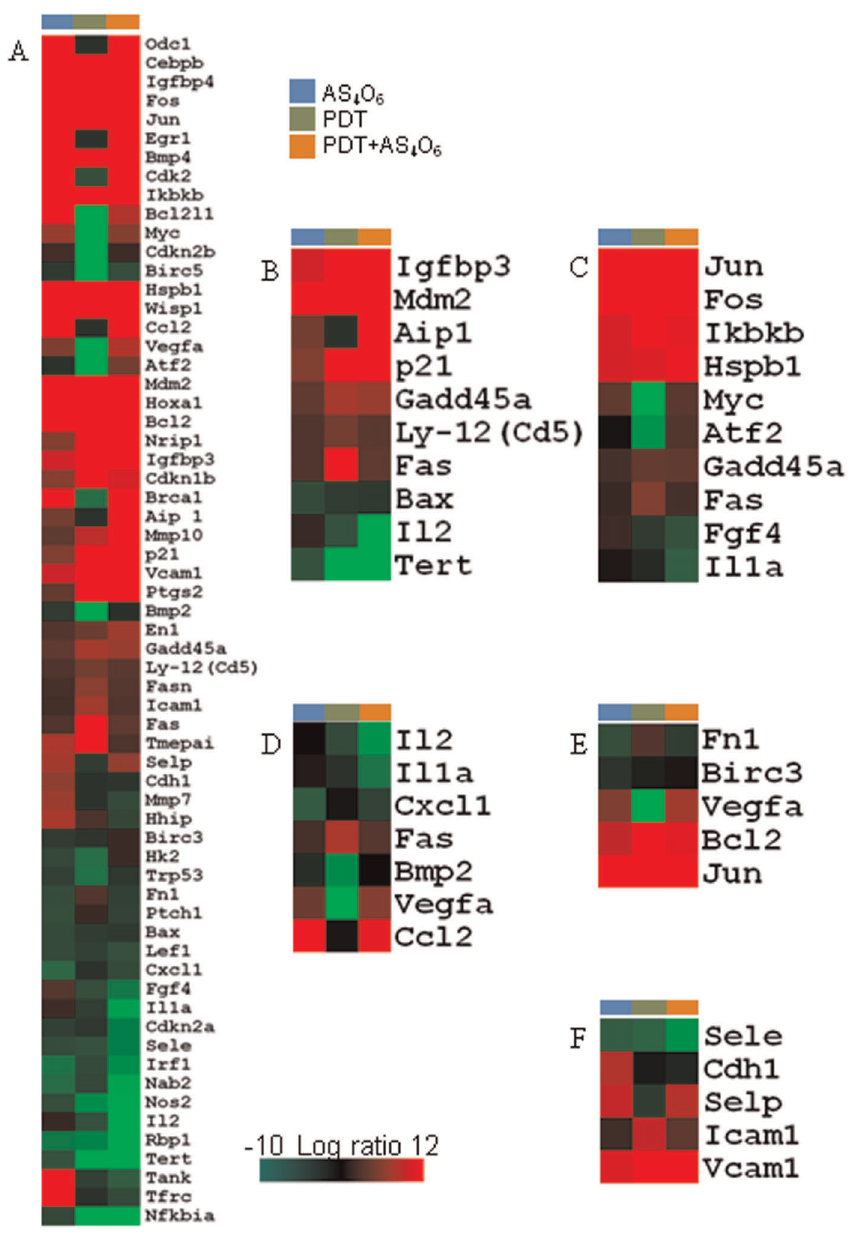
Figure 3 . Hierarchical cluster analysis. (A) All the data were median centred and clustered using a hierarchical clustering. A cluster image representing 63 of the genes is shown in matrix format, where rows represent individual genes and columns represent each assay. Each cell in the matrix represents the expression level of a gene in an individual assay. Red and green cells reflect high and low expression levels, respectively. (B) Ten genes (p53 and NEAT pathways) showing statistically significant differences in three groups are shown as a cluster image. (C) MAPK pathway as a cluster image. (D) Cytokine-cytokine receptor interaction pathway. (E) Focal adhesion pathway. (F) Cell adhesion pathway.